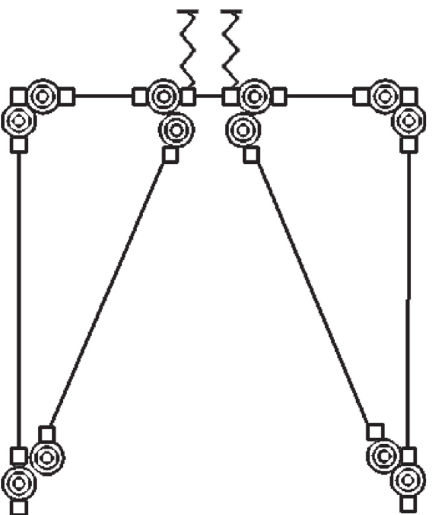
Figure 16: Analytical model of an eccentric bracing single bay frame.